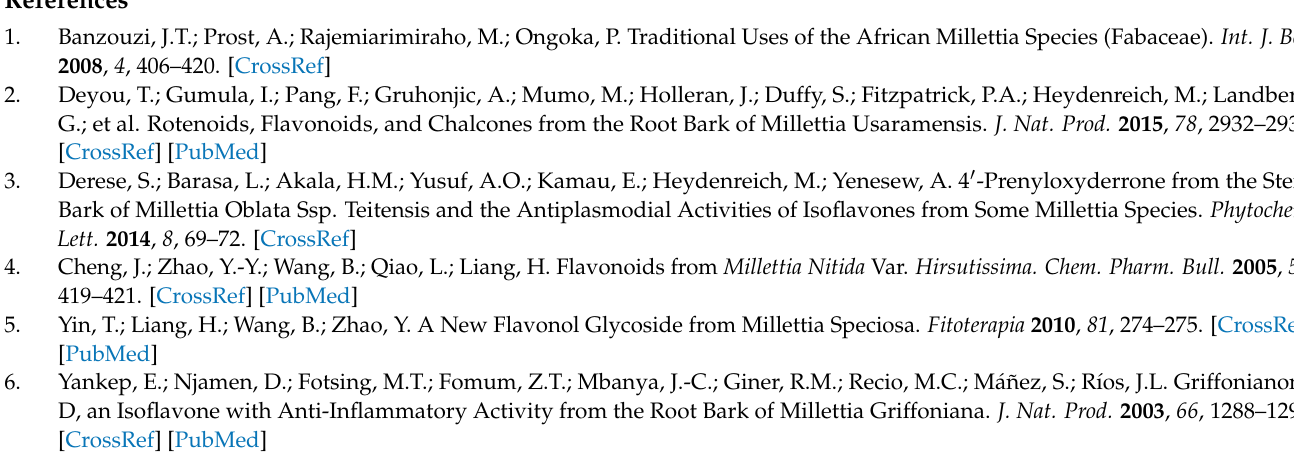
Figure S8: 2D binding model of Compound 4 in the active site of human intestinal α -glucosidase enzyme; Figure S9: 2D binding model of Compound 5 in the active site of human intestinal α - glucosidase enzyme. Table S1: α -Glucosidase inhibition of by the isolated compounds from Millettia speciosa . Table S2: Half-maximal inhibitory concentration (IC 50 ) values for acetylcholinesterase inhibition by the isolated compounds from Millettia